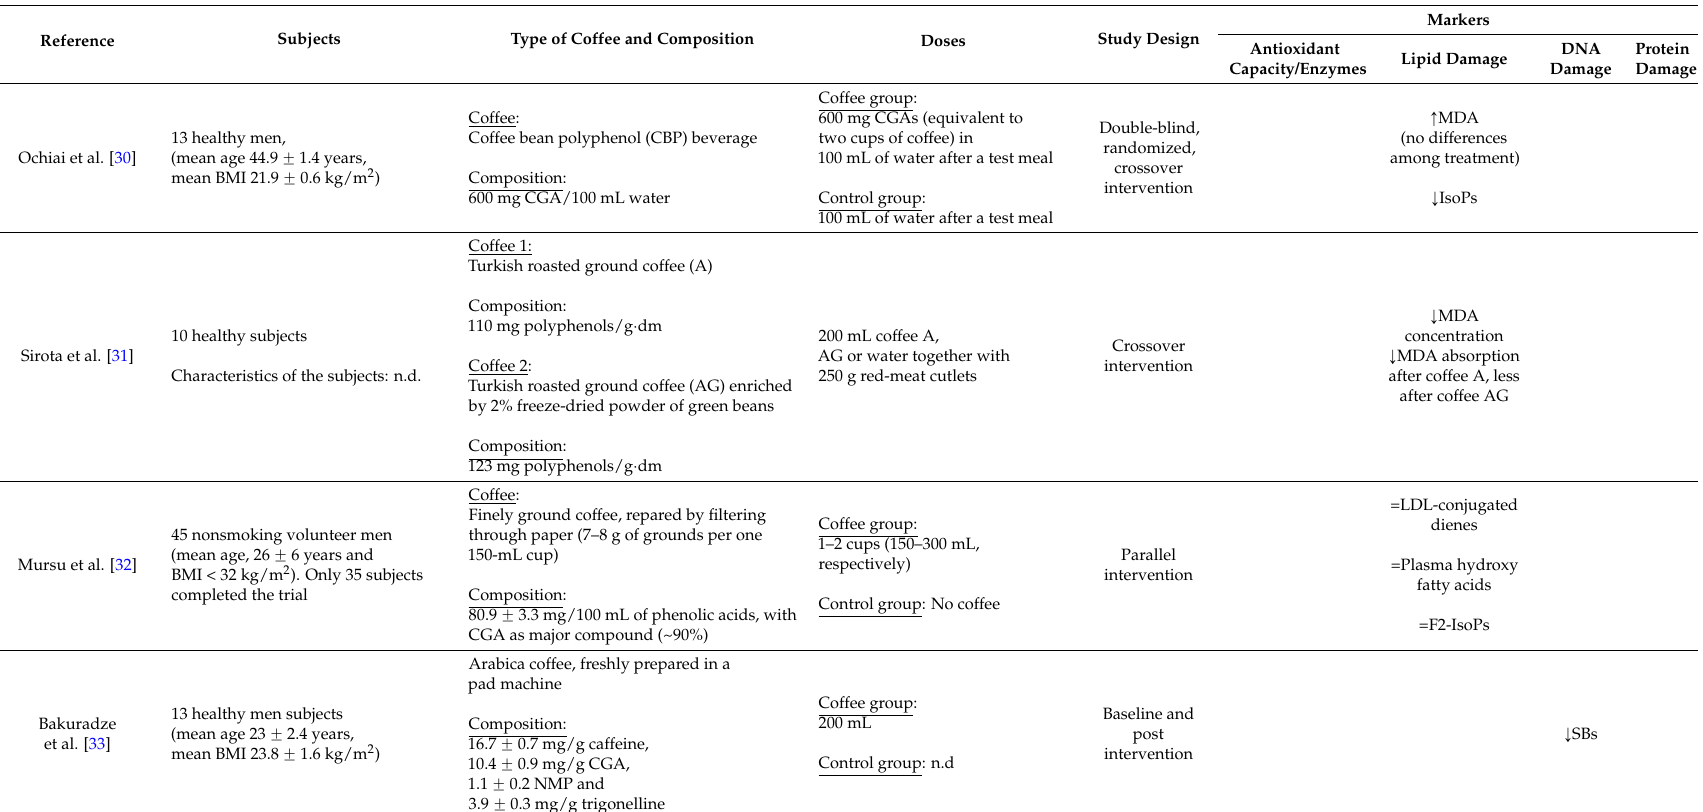
Control group: n.d